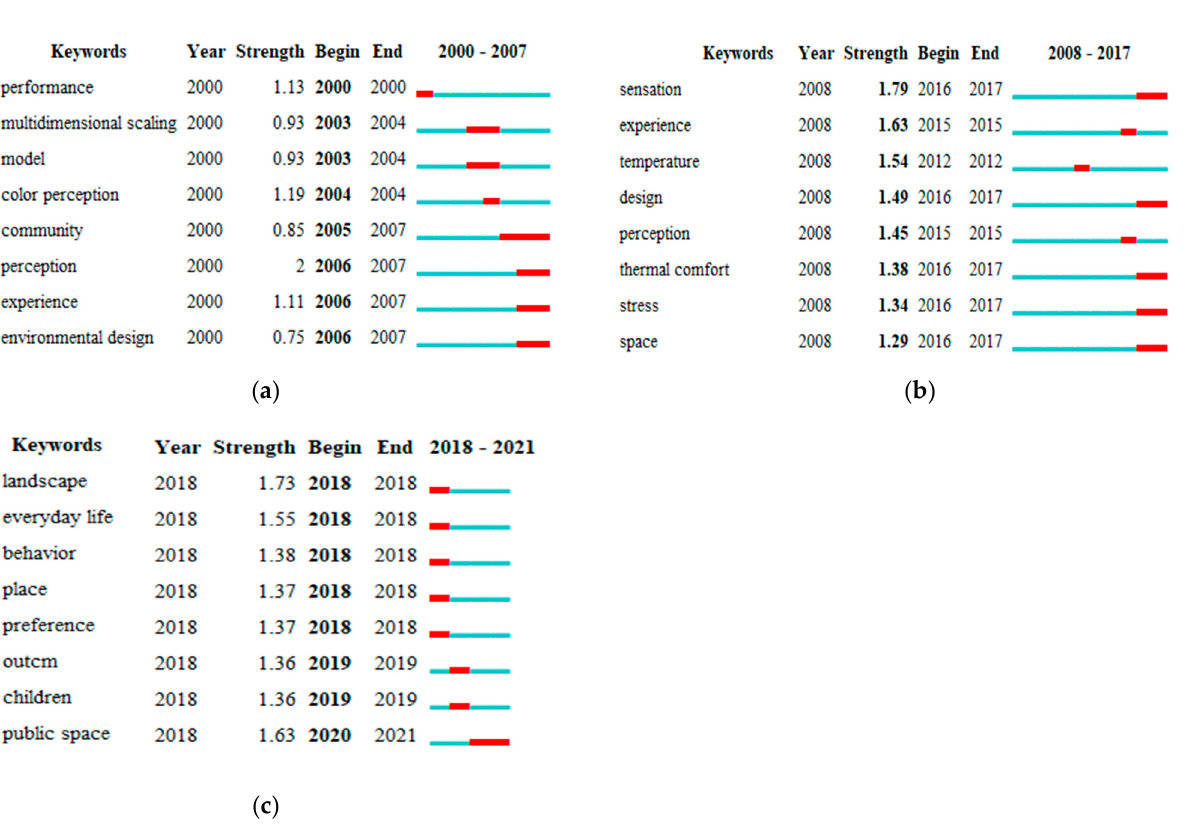
Figure 4. Burst detection analysis. ( a ) 2000–2007 keywords burstness. ( b ) 2008–2017 keywords burstness; and ( c ) 2018–2021 keywords burstness.